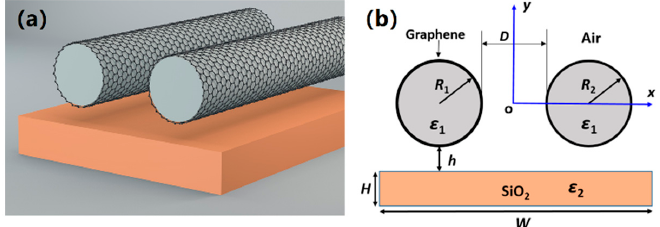
Figure 1. Schematic diagram of the proposed waveguide structure. ( a ) The three-dimensional view; and ( b ) the cross-sectional view.